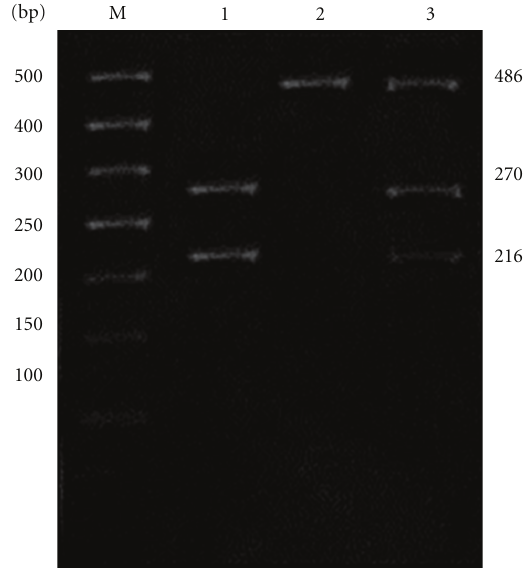
Figure 1: PCR restriction fragment length polymorphism results of − 1722 T to C substitution in CTLA-4 promoter region. (1) CC genotype; (2) TT genotype; (3) TC genotype.